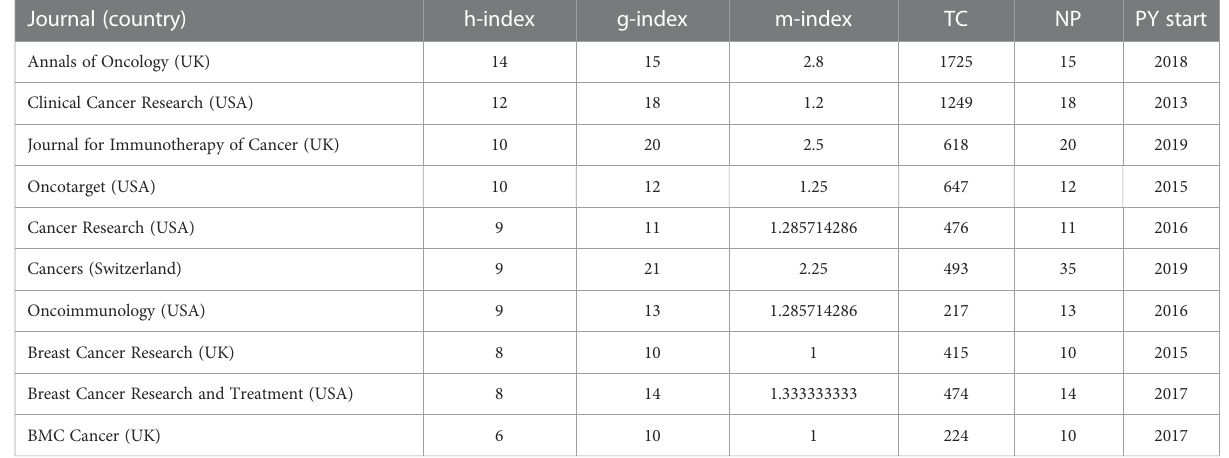
TABLE 1 Top 10 most in fl uential journals.